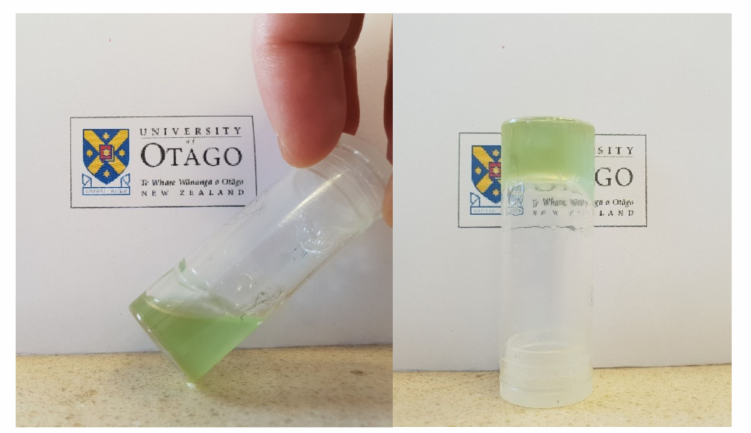
Figure 3. Gelation of a 30% solution of PEO 8 -40k-PDEGA (P5) on warming to RT from 0 ◦ C. To measure the behaviour of the gels with increasing temperatures, rheological mea- surements were carried at 30% w / v out using an oscillatory temperature step program. The gels were subjected to a temperature increase of 0.5 ◦ C, allowed to equilibrate for 180 s and then measurements were taken at an oscillatory stress of 10 Pa and frequency of 1 Hz. As opposed to a simple temperature ramp, this allows the gel some time to equilibrate at the temperature measured and should give a more accurate sol–gel transition